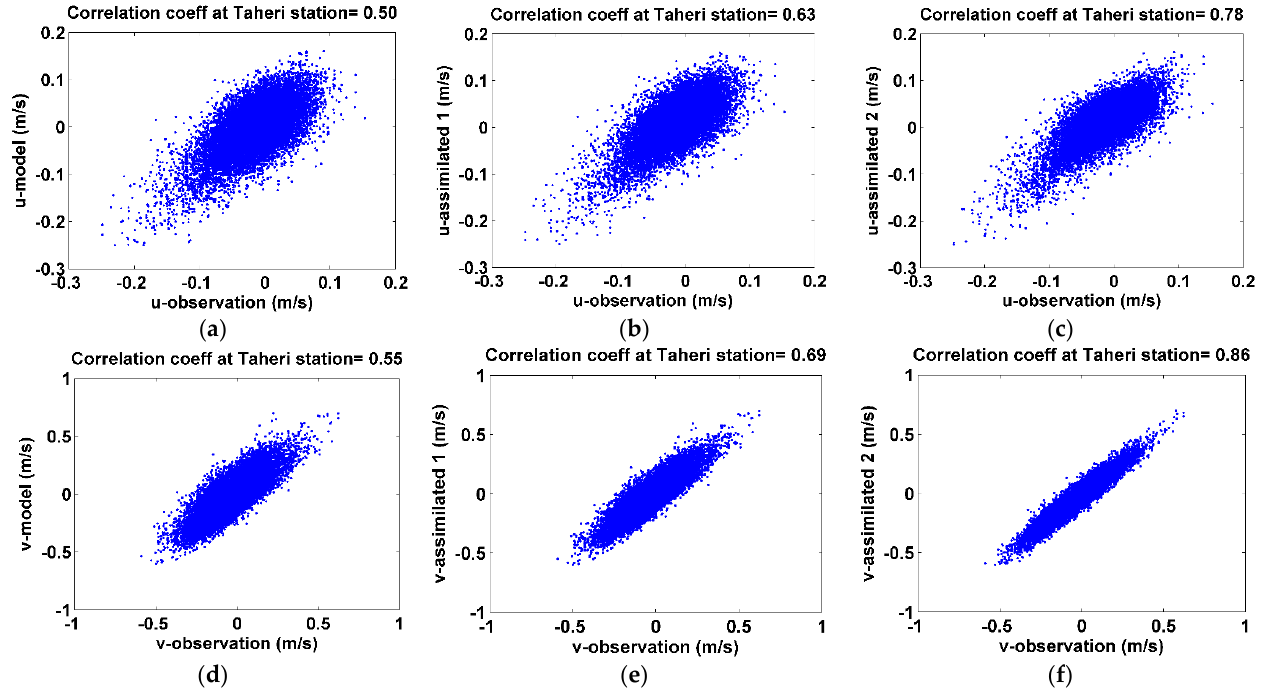
Figure 6. The correlations between the east–west component (u) of the SSC at Taheri current meter station and the model in three cases: ( a ) before data assimilation (calibration), ( b ) after data assimi ‐ lation without considering the variance–covariance matrices, and ( c ) after considering the variance– covariance matrices. The correlations between the observations of the north–south component (v) of the SSC at the Taheri current meter station and the model in three cases: ( d ) before data assimila ‐ tion, ( e ) after data assimilation without considering variance–covariance matrixes, and ( f ) consider ‐ ing variance–covariance matrixes. Table 5. RMSE values between the assimilated (calibrated) model and tide gauge observations at Rajaei and Khark control stations and current meter observation at Nayband control station. Different State of Objective Function